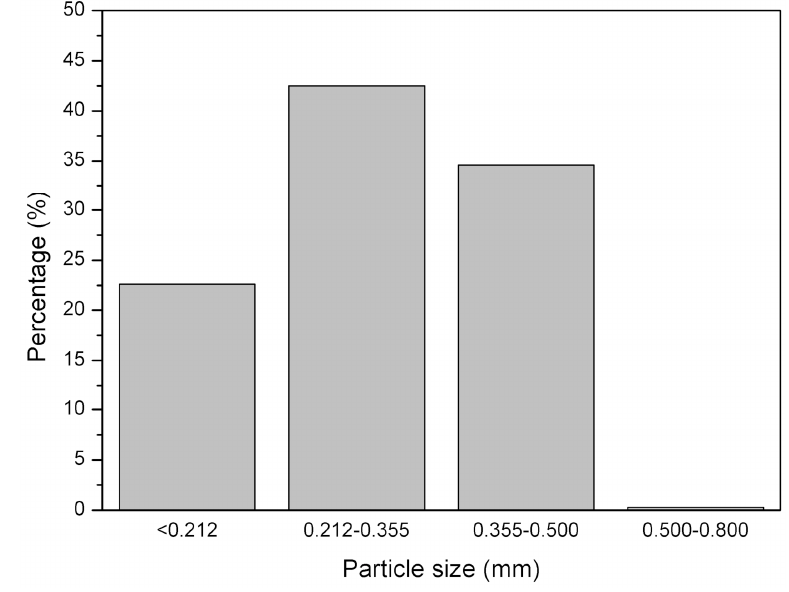
Figure 1. GTR particle size distribution .